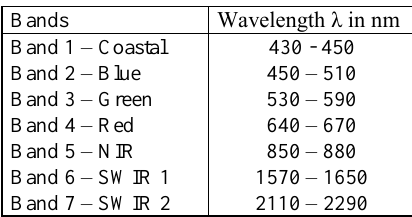
Figure 2. Calibrated Sentinel-1 image (upper left) and Gamma MAP Speckle Filter with different kernel sizes: 3x3, 7x7 and